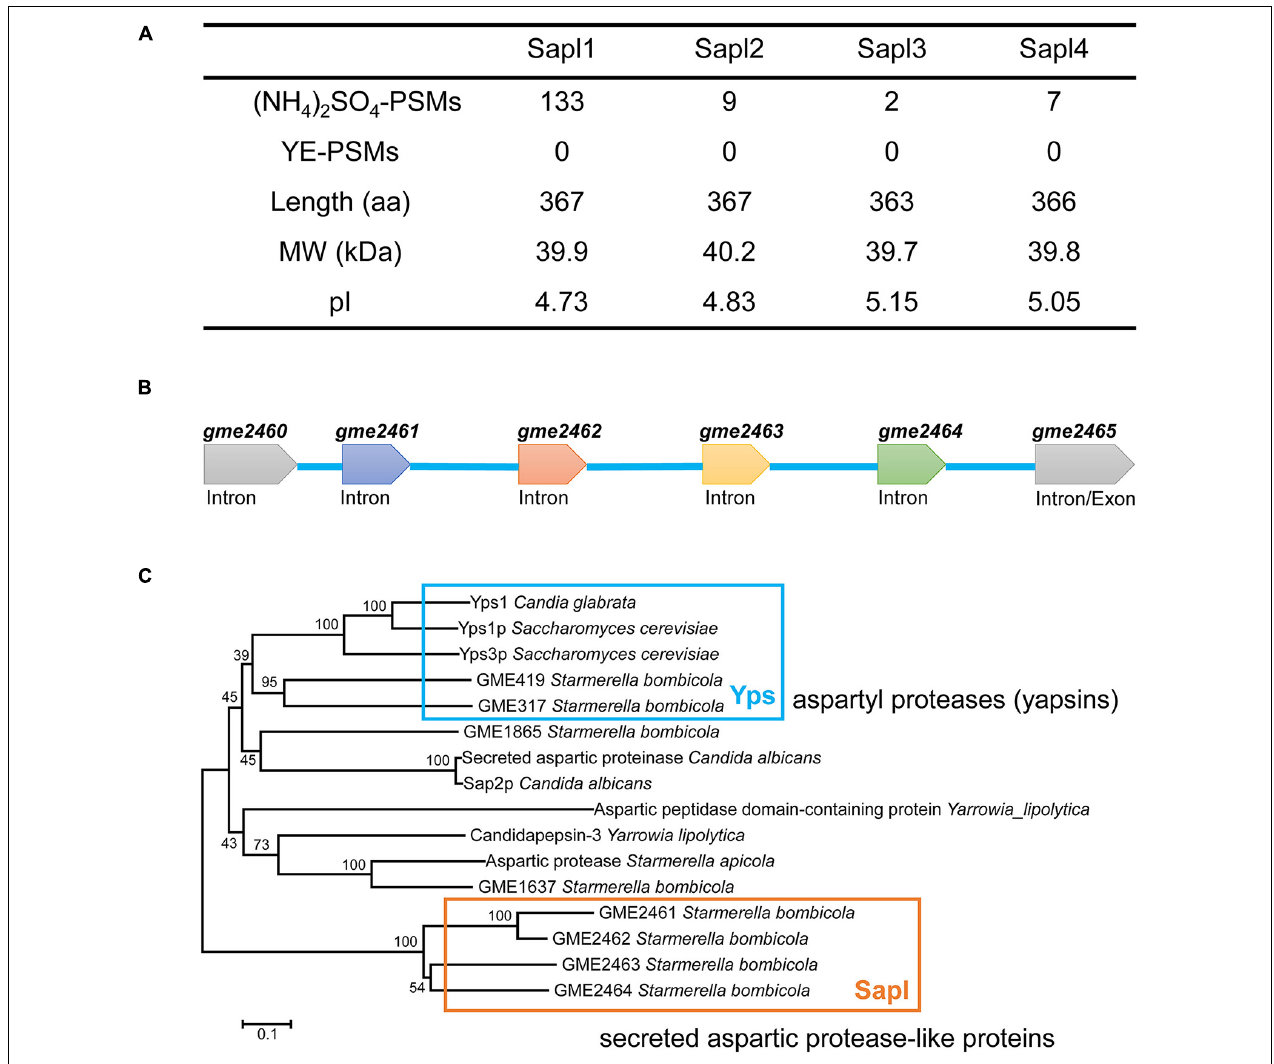
FIGURE 1 | Bioinformation analysis of Sapl. (A) Primary extracellular protein with ammonium sulfate or yeast extract (YE) as source. (B) sapl1 , sapl2 , sapl3 , and sapl4 genes cluster. (C) Phylogenetic analysis of S. bombicola CGMCC 1576 Sapl1, Sapl2, Sapl3, and Sapl4 with their homologous proteins using the neighbor-joining (NJ)